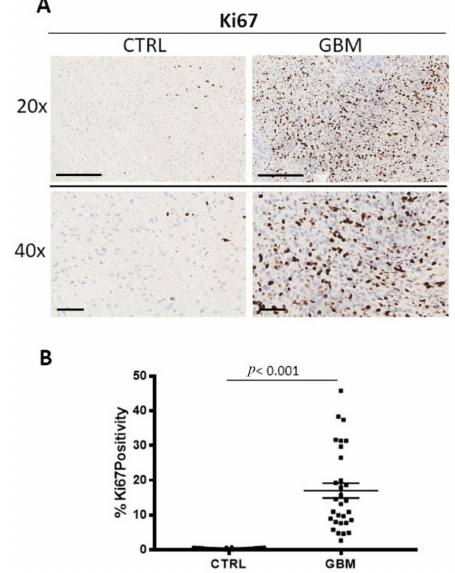
Figure 5. ( A ) Immunohistochemical staining for Ki67 as marker of proliferation in both the center of tumor (GBM) and in the healthy surrounding areas (CTRL). Scale bar: 60 µ m (40 × ), 200 µ m (20 × ). ( B ) Morphometric analysis indicating the percentage of Ki67 positivity in GBM and CTRL